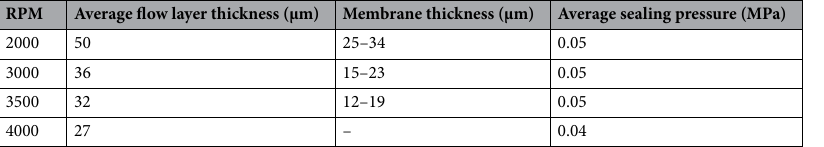
Table 2. Comparison of the sealing pressure of microfluidic devices with varying membrane thickness (N = 3).